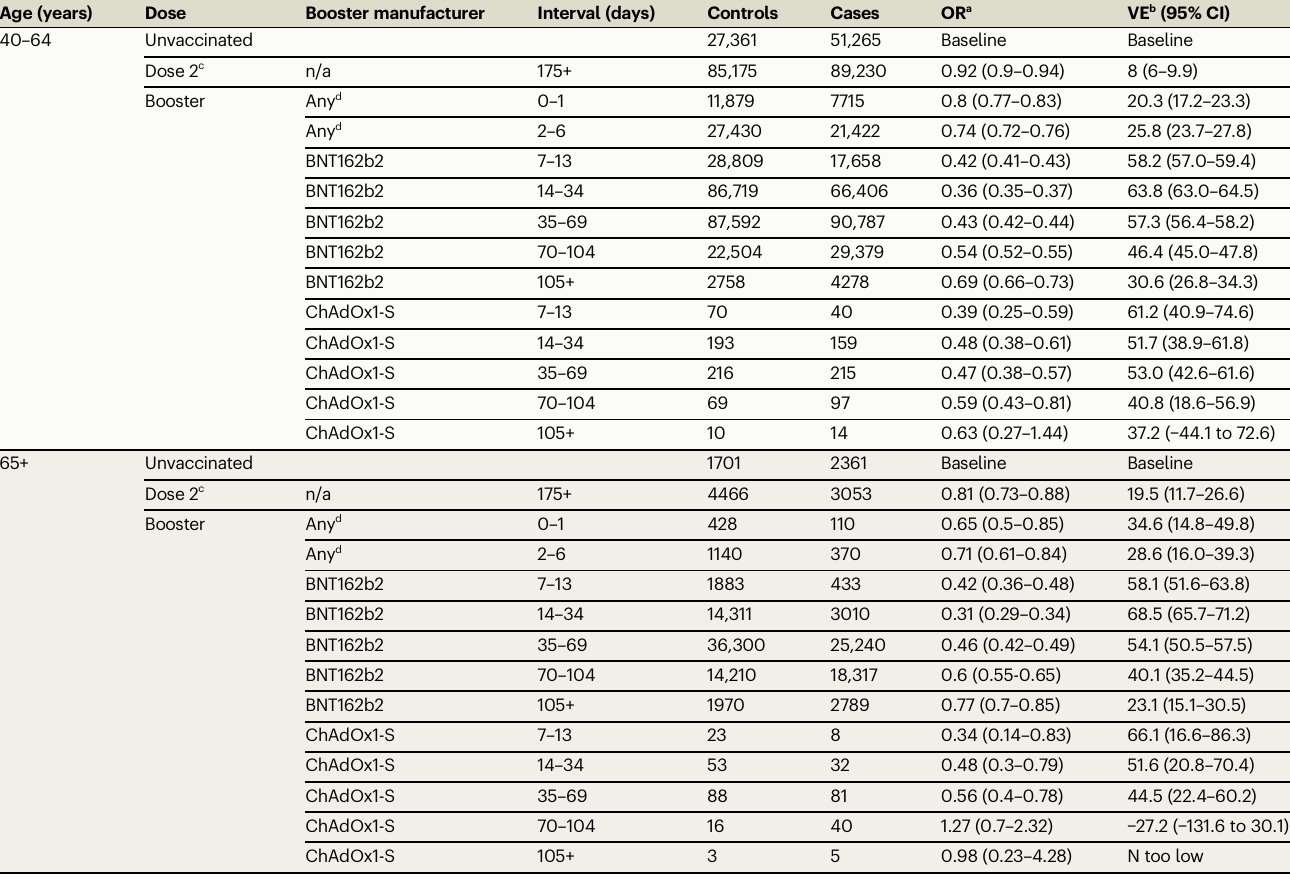
Table 3 | Effectiveness of the ChAdOx1-S and BNT162b2 booster vaccines against symptomatic disease following infection with the Omicron variant for adults aged 40 years and older in England